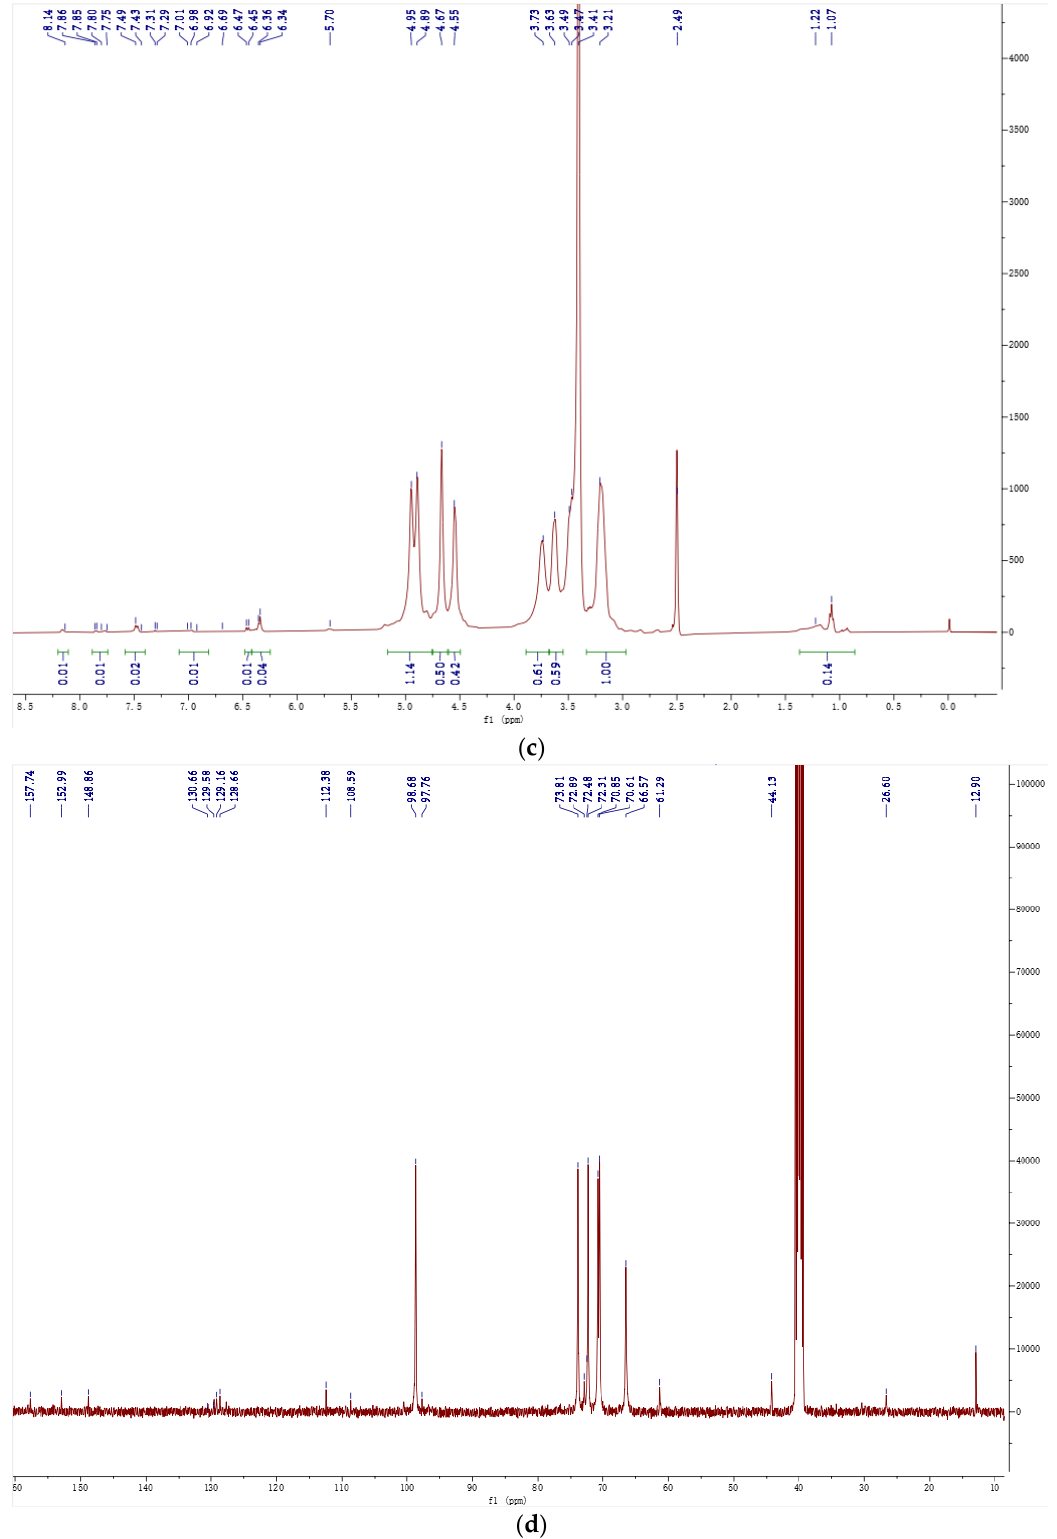
Figure 1. 1 H NMR and 13 C NMR spectra of Dextran-RhB ( a , b ) and SD-Dextran-RhB ( c , d ). The molecular weight was measured using gel permeation chromatography (GPC). The first peak presented the normal average number weight of the sample. The other peaks appeared at the last period and eluted from GPC column later, which also